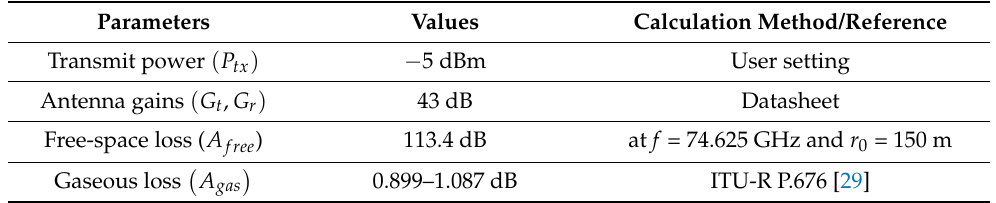
Table 1. Values of parameters in the link budget